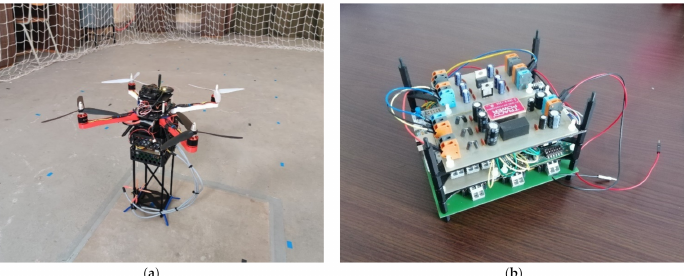
Figure 1. Customized UAV (Unmanned Aerial Vehicle) for magnetic field measurement: ( a ) before the measurement in the UAV Testing Hall; ( b ) details of the electronic measurement unit.